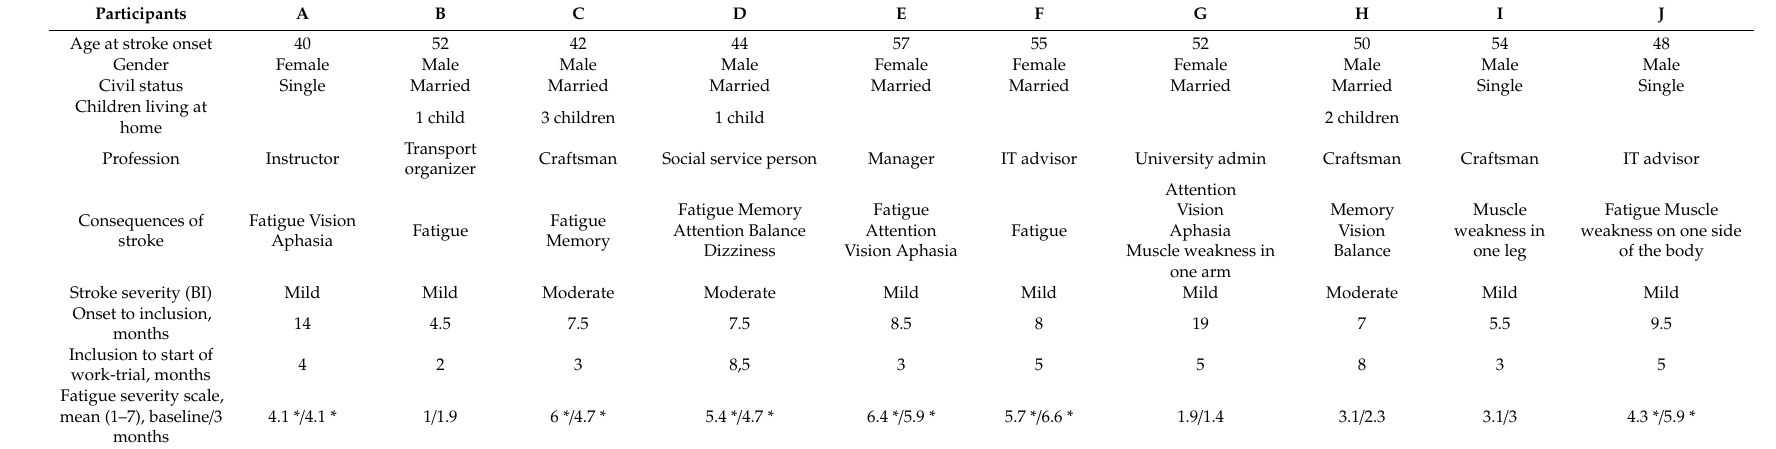
Table 1. Demographic characteristics, information on stroke severity and consequences, and time for inclusion in ReWork-Stroke for the participants ( n = 10). Participants